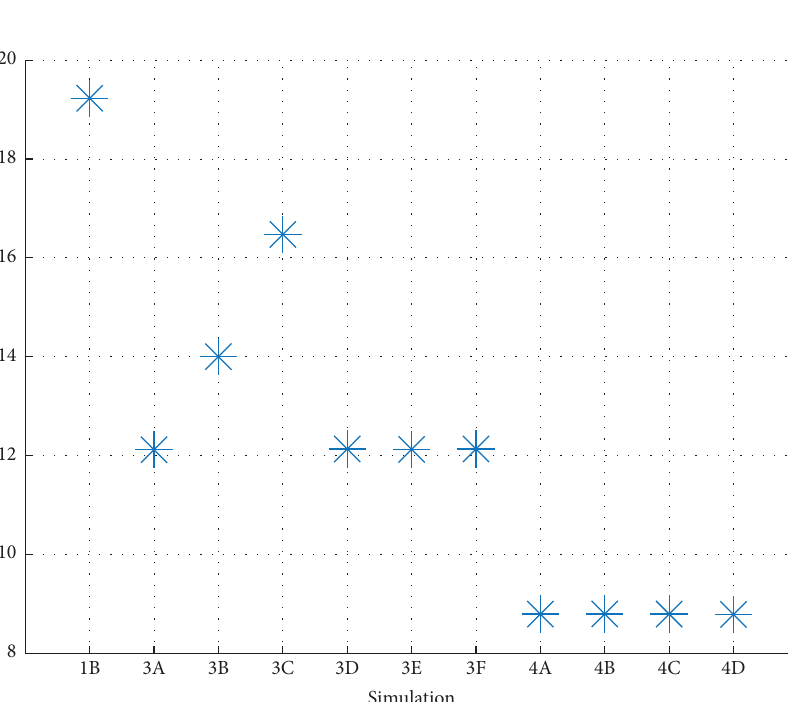
Figure 9: Maximum and minimum voltages across simulations 1B–4D.